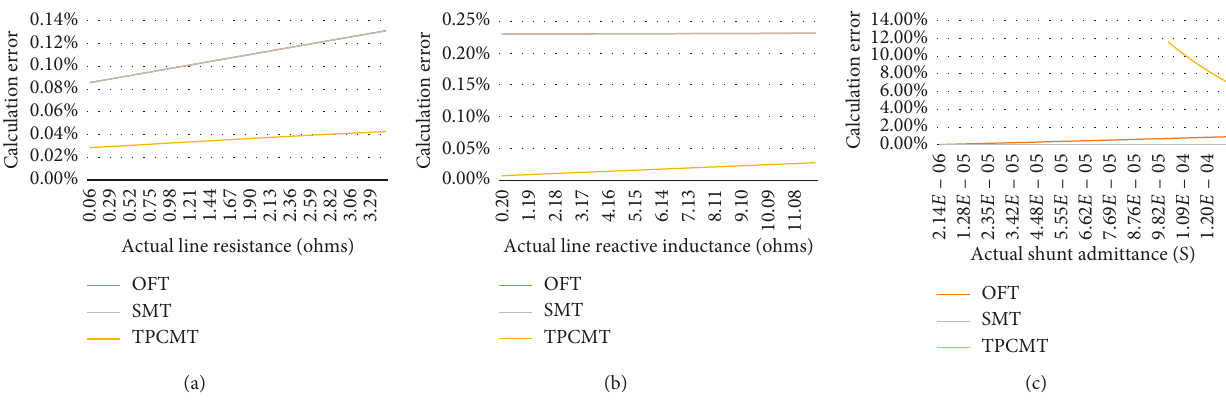
Figure 11: Calculation average errors of the six loading scenarios for the three methods under Category 4. (a) Resistance. (b) Reactive inductance. (c) Shunt